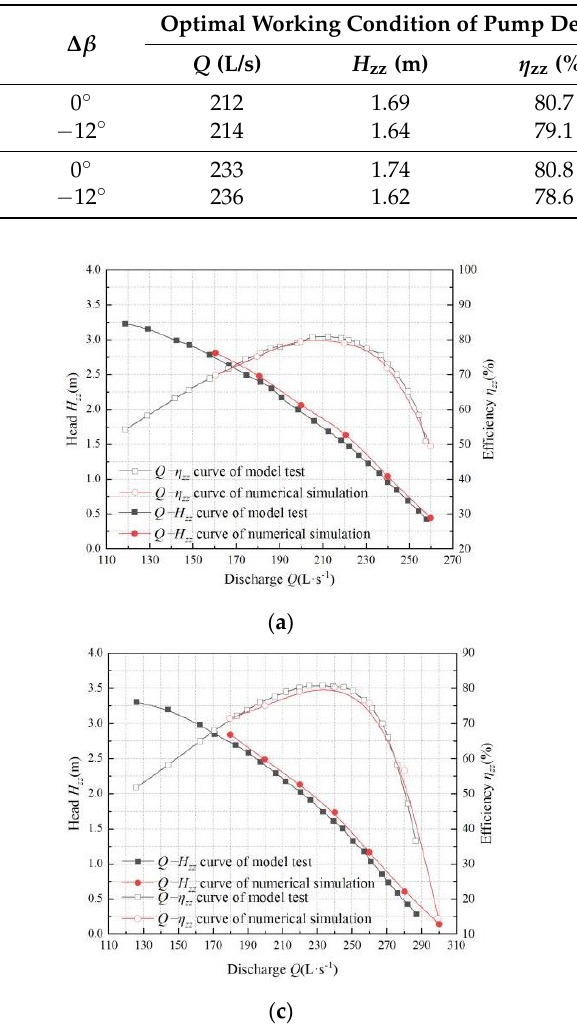
Figure 14. Comparisons of energy performance between model test and numerical calculation re- sults in pump device: ( a )  = −2°,  = 0°, ( b )  = −2°,  = −12 °, ( c )  = 0°,  = 0°, ( d )  = 0°,  = −12